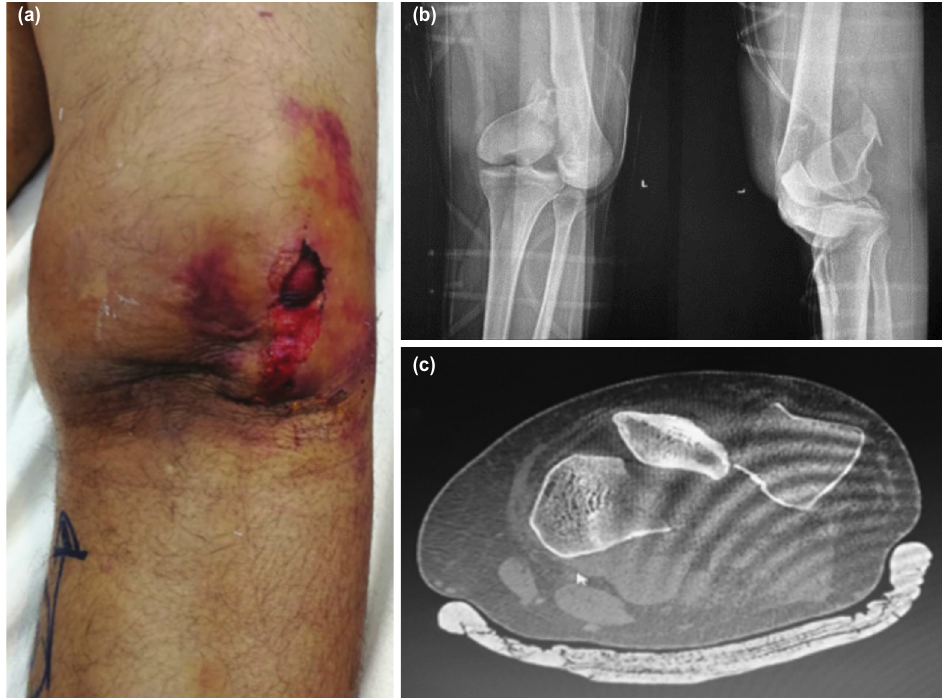
(a) Physical examination revealed a swollen left knee with a palpable gap at the anterior knee, patella cannot be felt. (b) Plain Fig. 1: radiograph of left knee showing patella was rotated and incarcerated in medial condyle femur fracture site (c) Axial view of left knee CT, showing rotational dislocation of the patella.